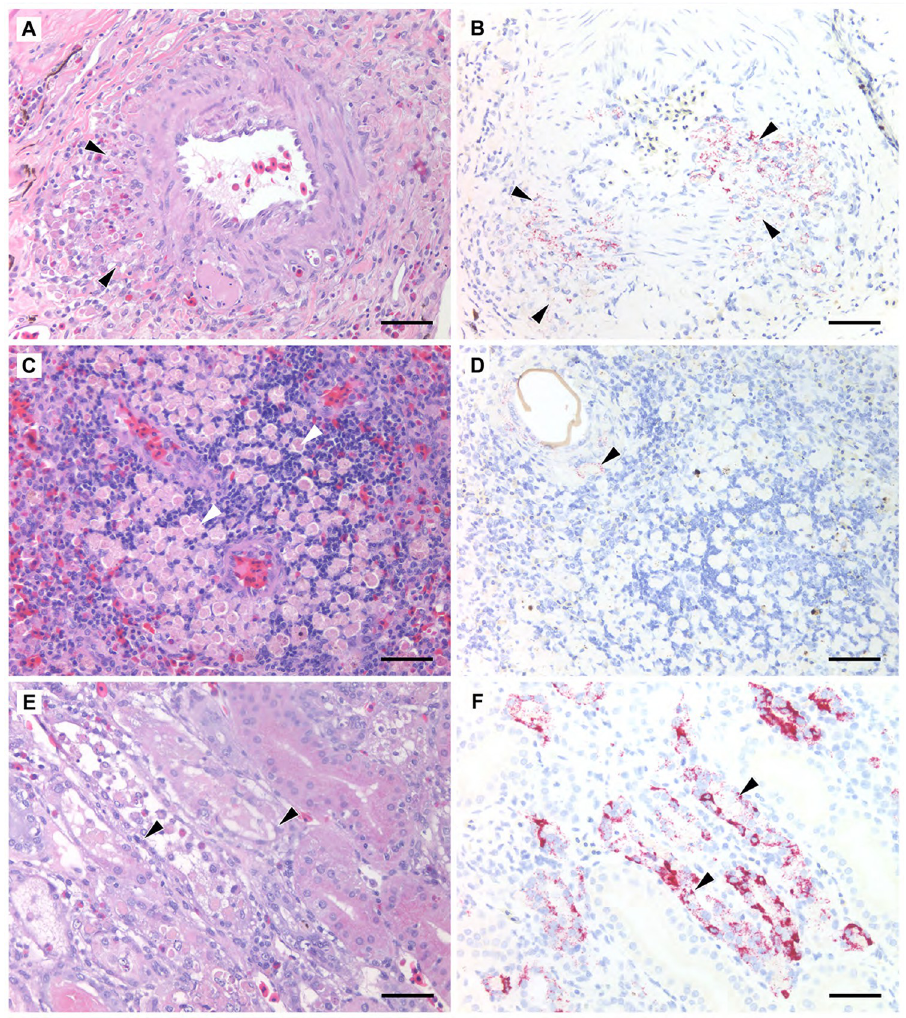
Fig 4. Histopathological lesions in visceral organs of Florida softshell turtles ( Apalone ferox ) infected with Turtle fraservirus 1 (TFV1). A) Vasculitis of a gastric serosal artery characterized by infiltration of the arterial wall and surrounding tissue by macrophages and heterophils (black arrowheads). The macrophages contain degenerate eosinophilic material and there are frequent necrotic cells within infiltrate. Hematoxylin and eosin. Scale bar = 75 μ m. B) Many leukocytes exhibit positive labelling (black arrowheads) for TFV1 by RNAscope in situ hybridization (ISH). Scale bar = 75 μ m. C) Collection of macrophages within the spleen in which the cytoplasm contains globular eosinophilic material and scant brown pigment granules (white arrowheads). Hematoxylin and eosin. Scale bar = 75 μ m. D) There is no labelling of these macrophages for TFV1 by ISH; however, there is positive staining of macrophages (black arrowhead) and multinucleated giant cells that comprise a granuloma formed around a spirorchiid trematode egg. Scale bar = 75 μ m. E) Macrophages and heterophils infiltrate renal tubules. The tubular epithelium is attenuated, and sloughed cells and leukocytes fill the lumina (black arrowheads). Macrophages contain degenerate cytoplasmic material as observed in other lesions. Hematoxylin and eosin. Scale bar = 75 μ m. F) There is widespread staining of the abnormal tubular epithelium (black arrowheads) for TFV1 by ISH. Scale bar = 75 μ